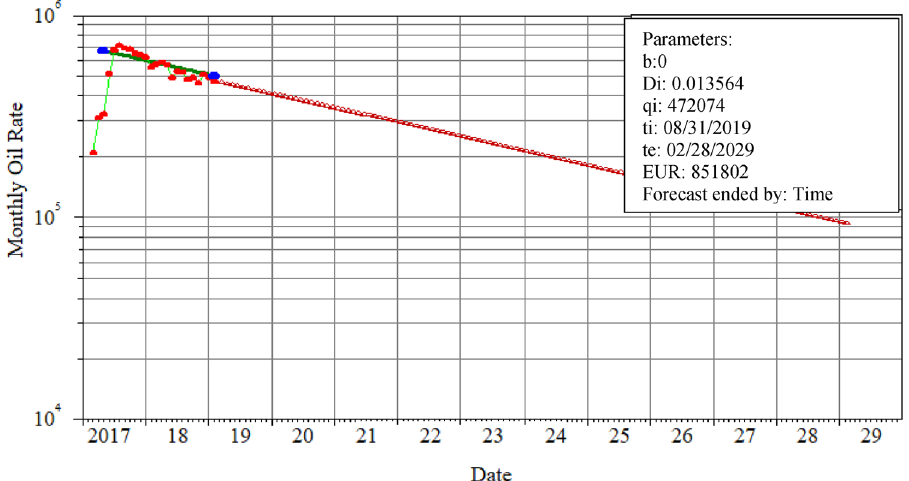
Fig. 12 Decline curve analysis (DCA) for target reservoir unit